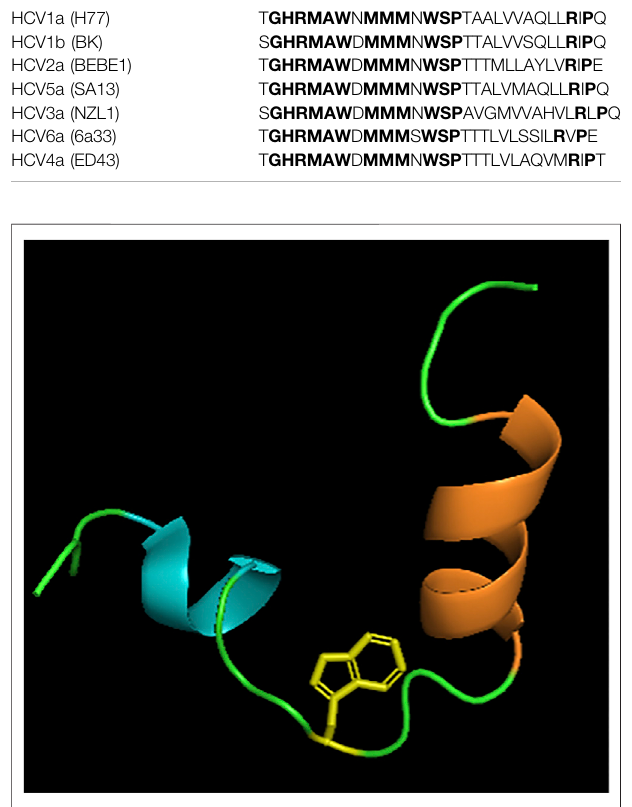
FIGURE 7 | Structure of E1 pre-transmembrane region determined by NOEexperiments(Spadaccini etal.,2010).TwoalphahelicesMAWDM(cyan) and AALVVAQLL (orange) separated by a bend illustrated by Trp326 (yellow). PDB code: